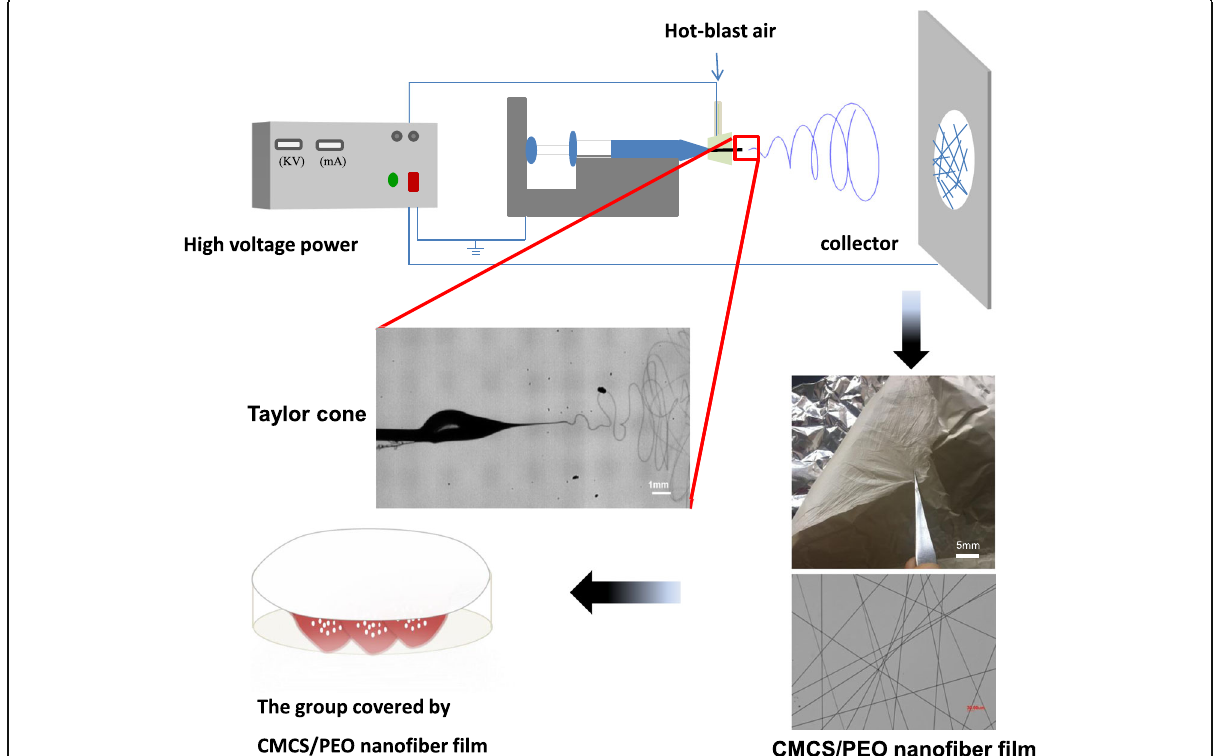
Fig. 1 Diagram of the method for preparing the CMCS/PEO nanofiber membrane for strawberries